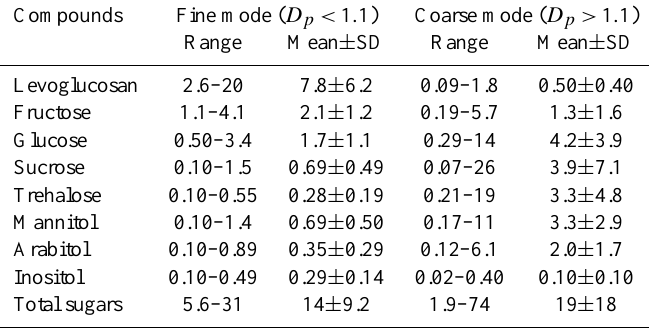
Table 3. Concentrations (ngm − 3 ) of sugar compounds in the size-segregated aerosols from Sapporo, northern